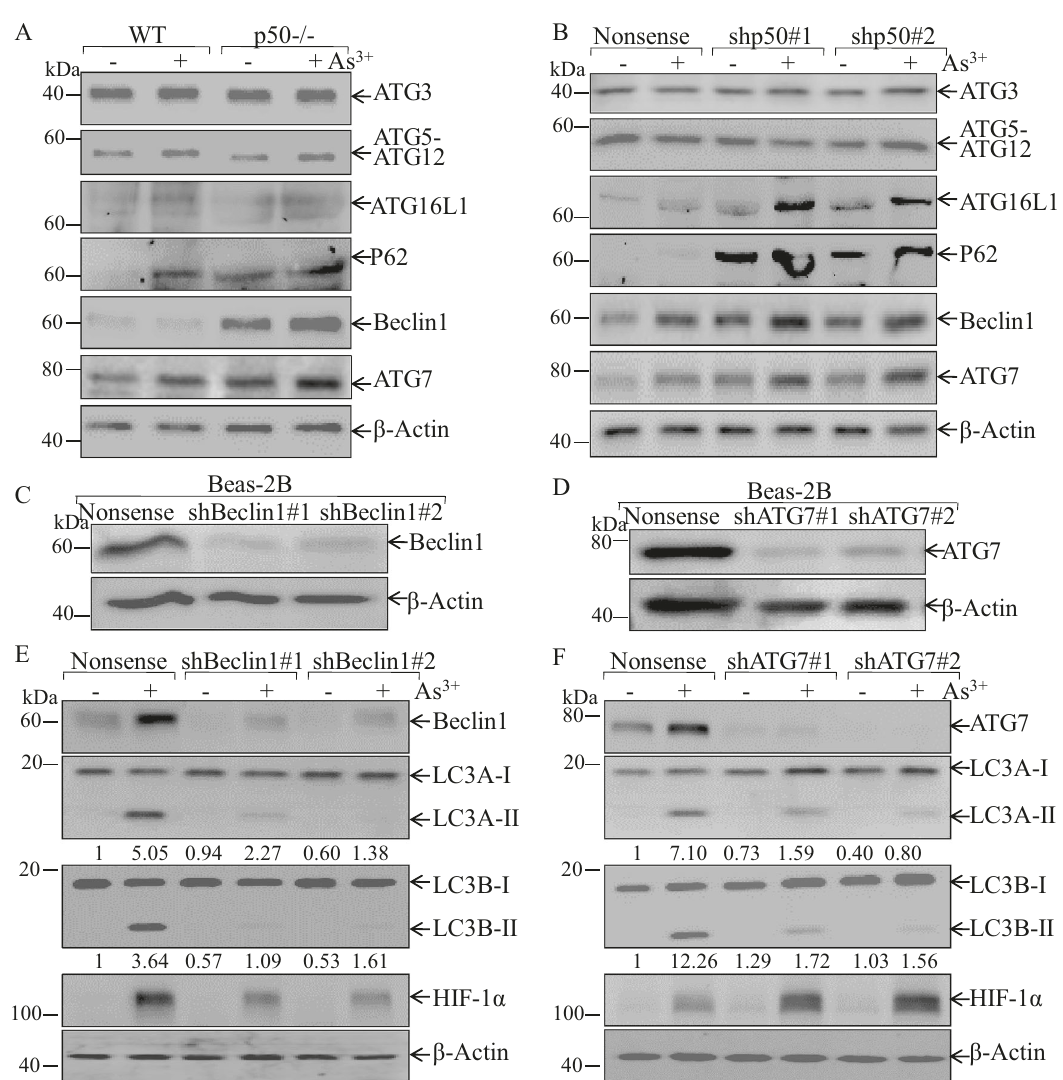
Fig. 3 p50 inhibition of autophagy was mediated speci fi cally by attenuation of ATG7, but not Beclin1, following arsenite treatment. A , B WT, p50 − / − , Beas-2B(Nonsense), and Beas-2B(shp50) cells were treated with 20 μ M arsenite for 24 h as indicated. The cells were extracted and cell lysates were subjected to western blotting assay by using the indicated antibodies. C – F shRNA ATG7 and shRNA Beclin1 were stably transfected into Beas-2B cells, and the stable transfectants were identi fi ed as indicated ( C , D ); the stable transfectants were treated with arsenite treatment for 24 h and the cell extracts were subjected to western blot for determination of protein expression by using indicated antibodies, the ratio of LC3 II/LC3 I was quanti fi ed ( E , F ). exhibited that Sp1 was an p50 downstream effector being knockdown Sp1 in Beas-2B(shp50) cells, and the Sp1 knockdown responsible for p50 inhibiting ATG7 transcription. ef fi ciency was identi fi ed as shown in Fig. 4F. Upon arsenite treatment, Sp1 knockdown in Beas-2B(shp50) cells impaired ATG7 p50 suppressed Sp1 mRNA stability through inhibiting protein expressions, and also attenuated the LC3 conversion from Nucleolin (NCL) expression LC3-I to LC3-II, as well as HIF-1 α protein accumulation as To determine the mechanisms underlying p50 inhibition of Sp1 compared with those observed in the scramble control transfec- expression, Sp1 mRNA were evaluated in Beas-2B(shp50) cell and tant, Beas-2B(shp50/nonsense) cells (Fig. 4F). These results clearly